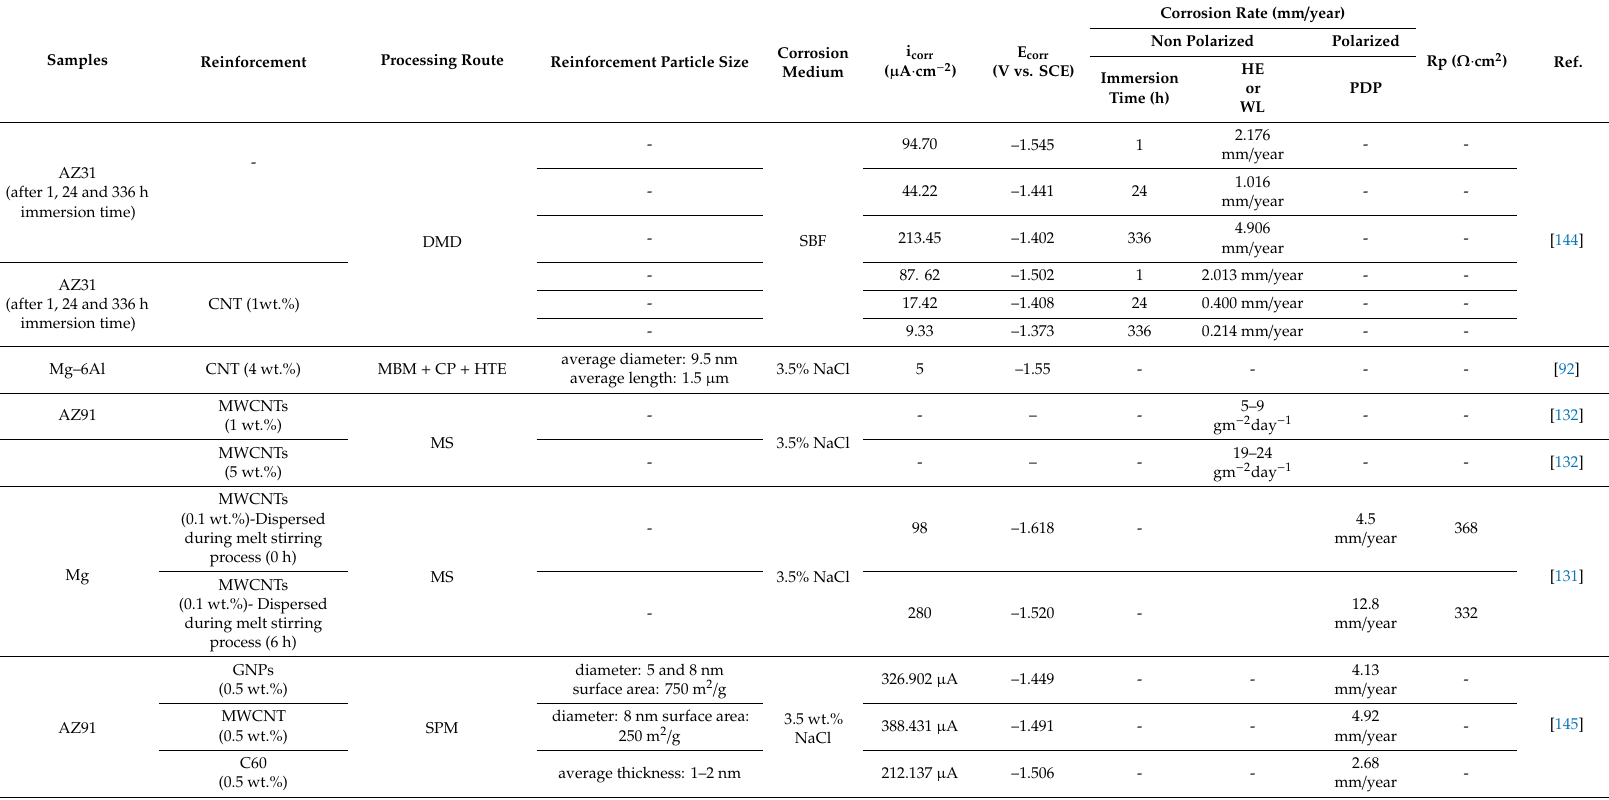
Table 2. Corrosion properties of carbon nanotube-reinforced magnesium